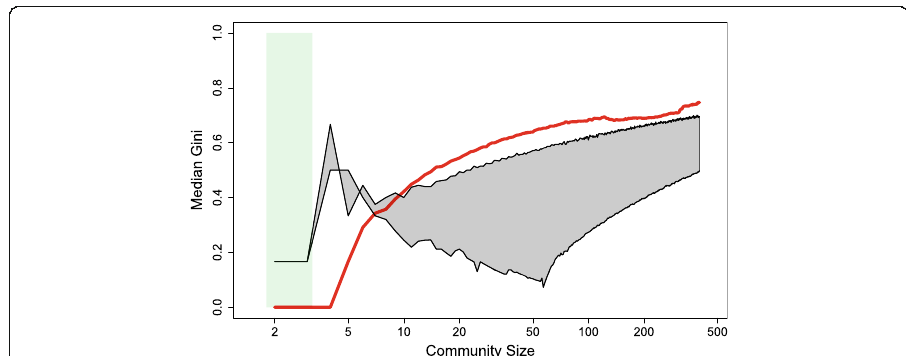
Fig. 2 Measure of degree inequality within the community plotted against size. Red is the median line of networks from real-life data, the grey envelope are simulations of Generalized Barabasi-Albert networks with 0.1 ≤ α ≤ 2, and the light green band marks the range where we used the ordinary